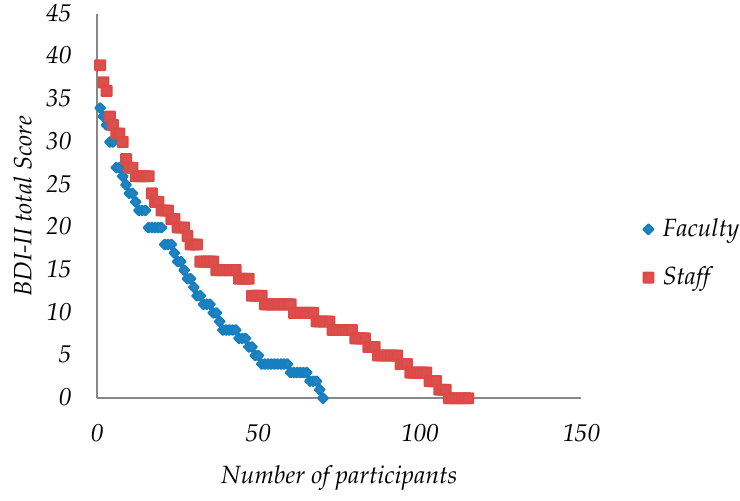
Figure 4. Smoothed density plot of BDI-II scores for staff and faculty.